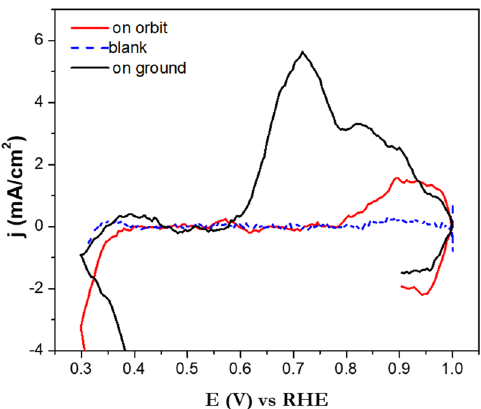
Fig. 7 Cyclic voltammetry pro fi les nanocube Pt nanoparticle- Vulcan electrode in 0.05 M (NH 4 ) 2 SO 4 0.18 M NaOH solution at pH 12.9 and scan rate of 10 mV/s. Under earth and atmospheric conditions (black line), on-orbit (red line) and 0.18 M NaOH used as blank (blue